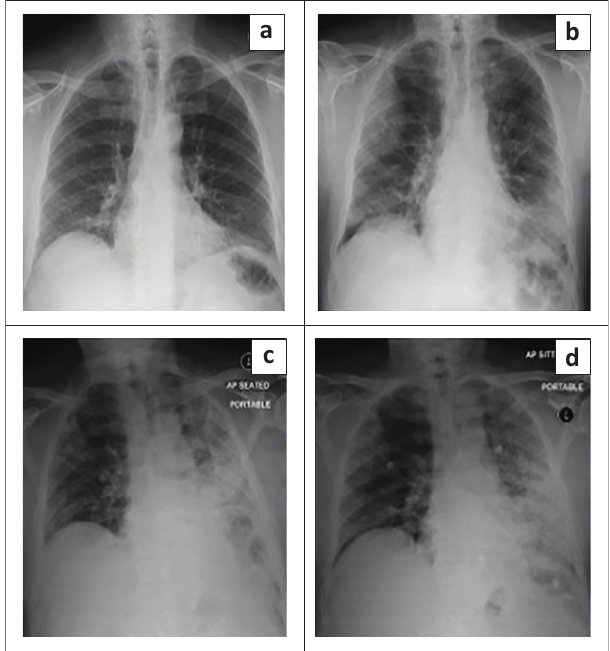
FIGURE 7: Chest radiographs from (a) 03 October 2013, (b) 27 June 2020, (c) 03 July 2020 and (d) 11 July 2020): 2013 normal baseline radiograph. Serial images demonstrate progressive unilateral left lower lobe and lingular air space opacification, consolidation and volume loss. Focal right upper lobe consolidation with ‘air